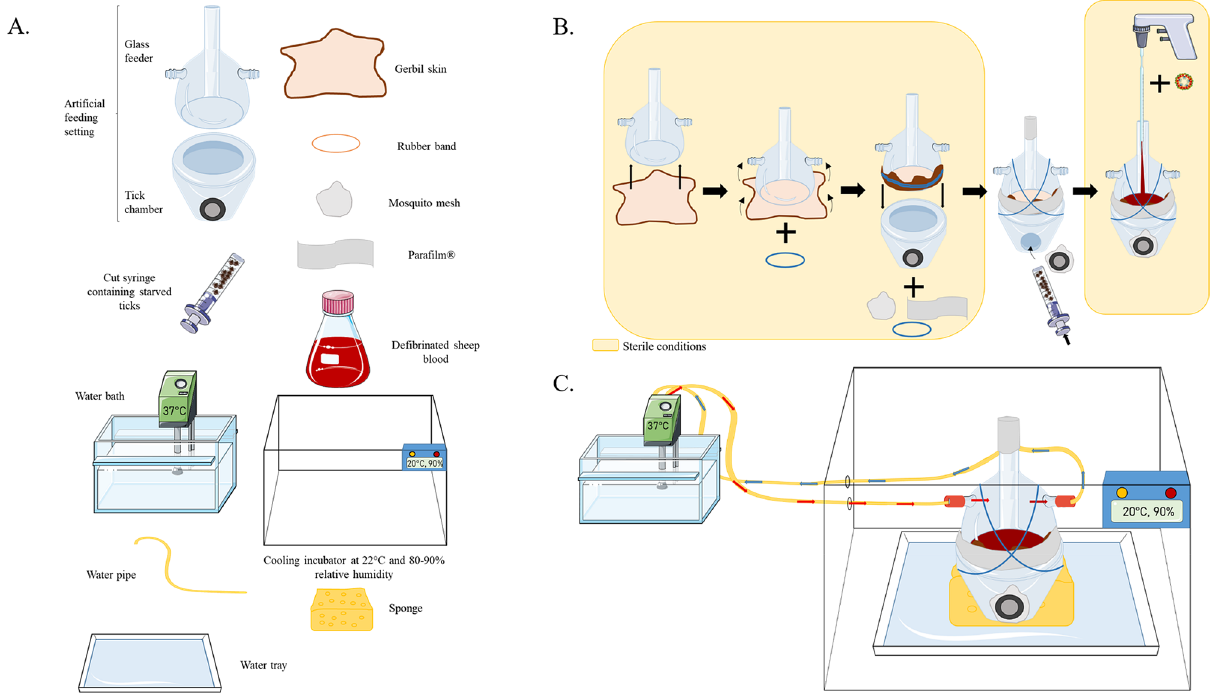
Figure 3. Schematic representation of ( A ) the necessary material, ( B ) the setting of the tick artificial feeding system and ( C ) the complete assembly of the system (adapted from 13